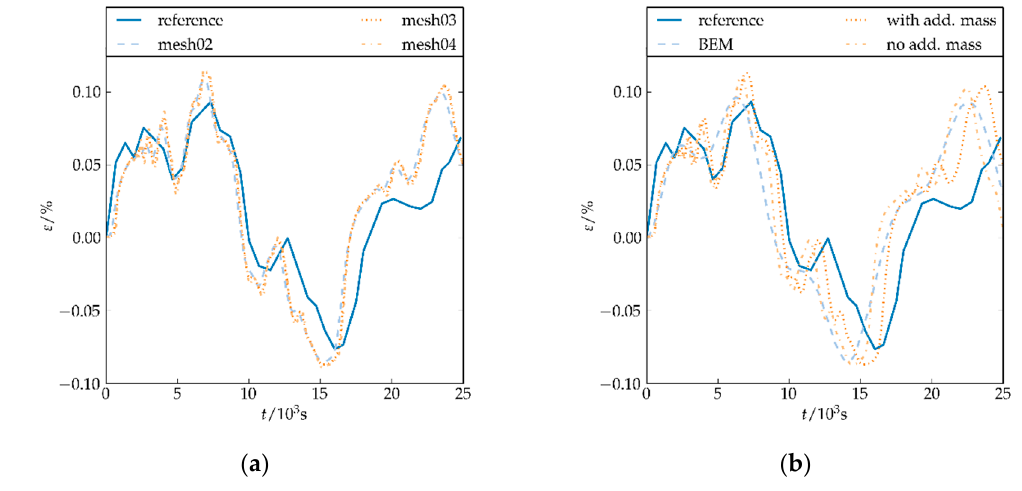
Figure 7. Strain response of deformable cylinder (reference data from [34,35]): ( a ) Comparison of different mesh configurations using ρ s = ρ s ,2 ; ( b ) Comparison of different structural densities.